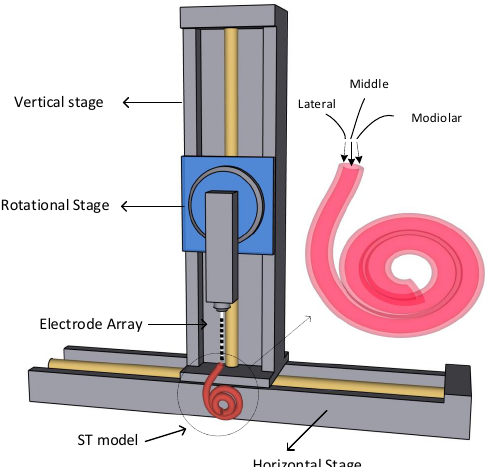
Figure 2. Three-DoF actuation system for electrode array insertion in ST model. Graphical represen- tation of insertion from three different directions are in the inset.